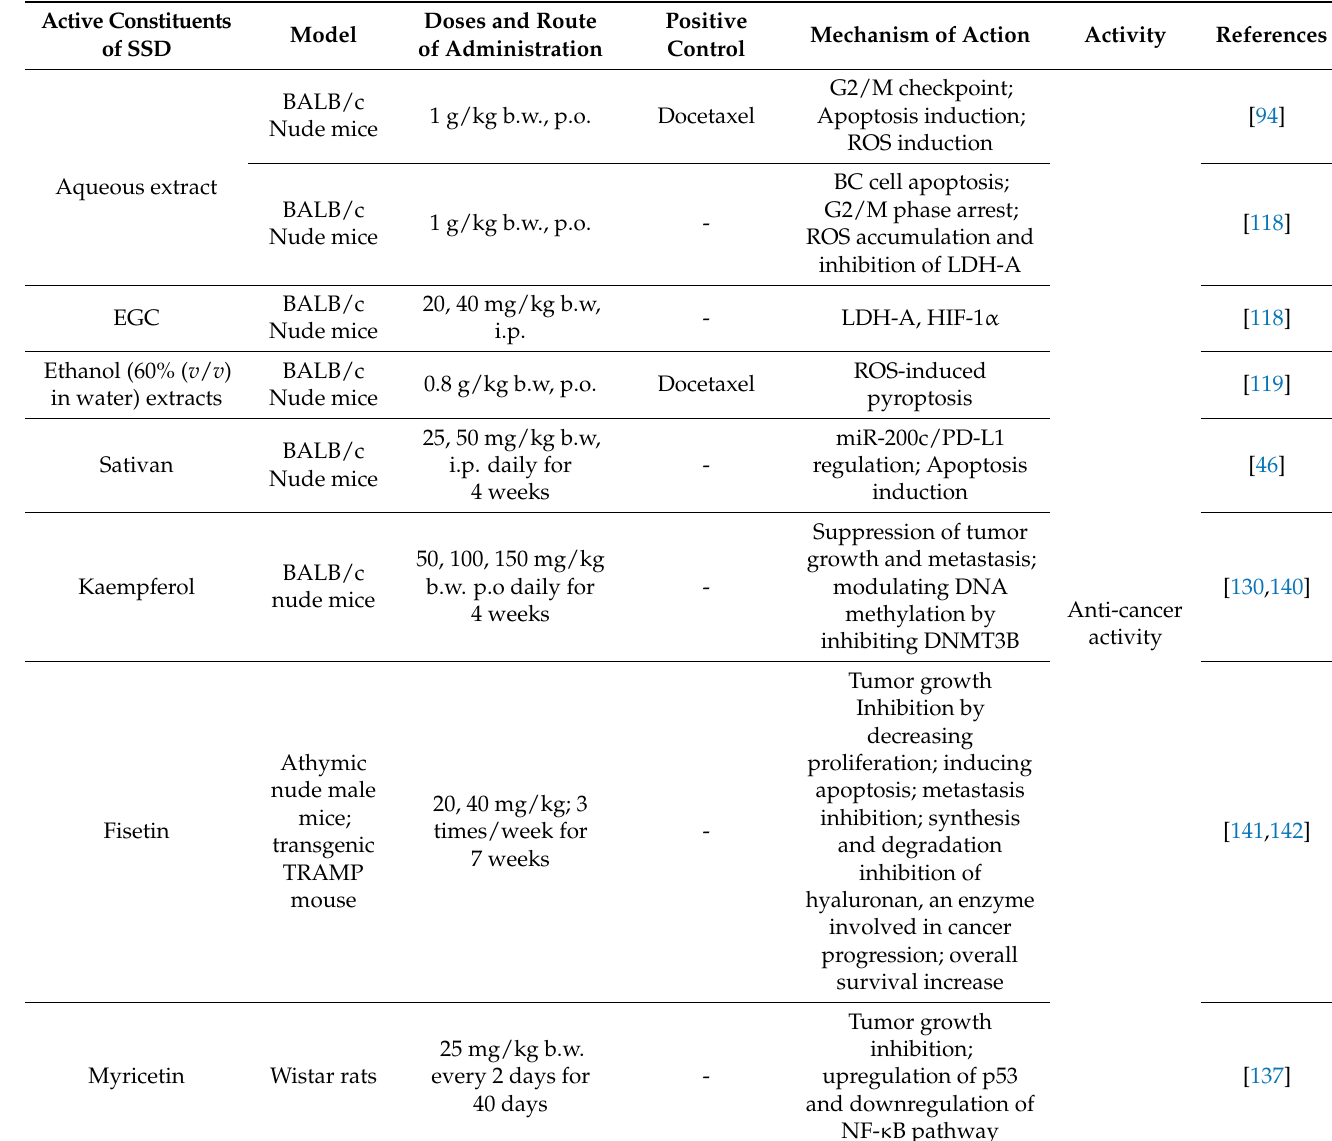
Table 3. In vivo anticancer activities of